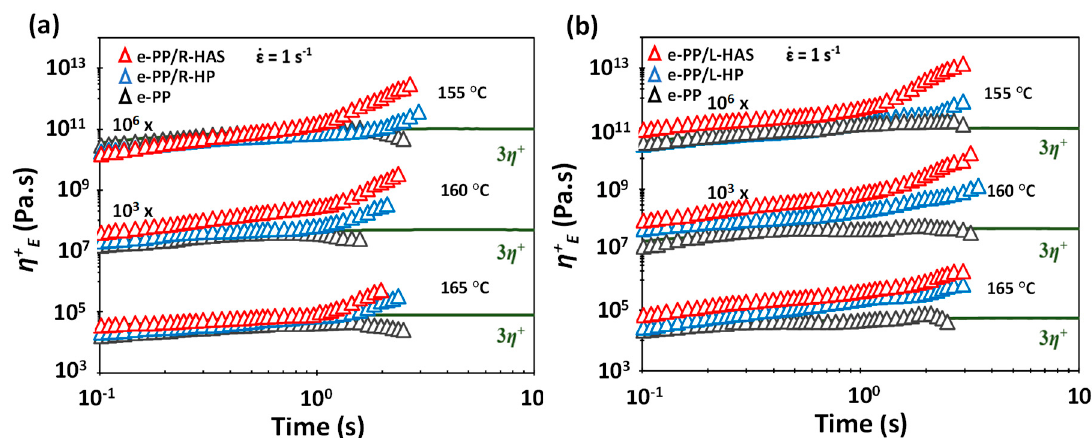
Figure 12. Tensile stress growth coefficient, η + E , of e-PP, e-PP/HP microfibers, and e-PP/HAS microfibers at Hencky strain rates 𝜀(cid:4662) of 1 s − 1 at various temperatures ( a ) with R-HAS and R-HP and ( b ) with L-HAS and L-HP. Standard deviation bars have not been included because the ranges were smaller than the magnitude of data points.